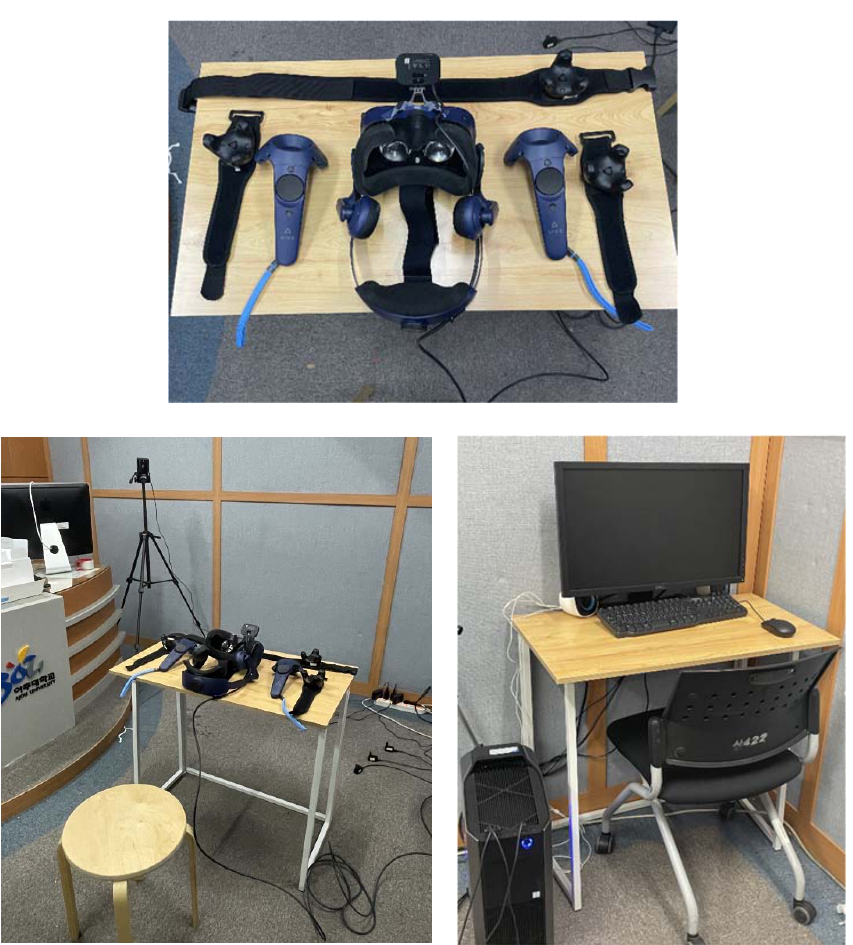
Figure 3. Experimental equipment and environment: VR equipment ( top ); experimental environ- ment ( bottom left ); the computer used for the experiment ( bottom right